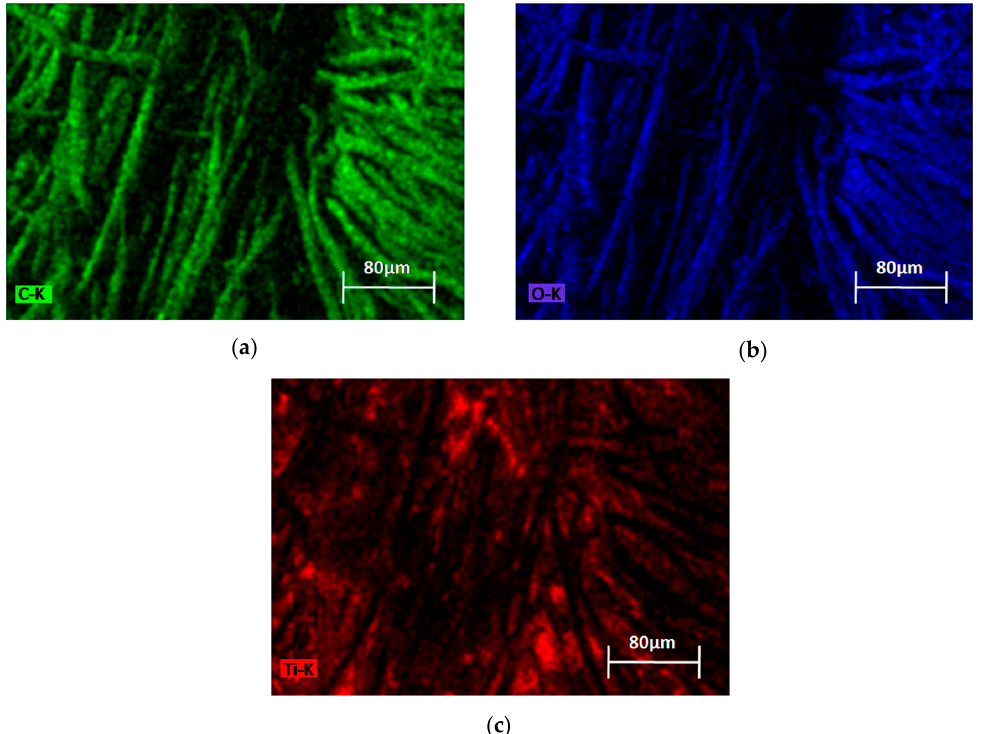
Figure 3. EDX mapping of RGO / TiO 2 coated CO (( a )- map of the C element, ( b )- map of the O element, ( c )- map of the Ti element).